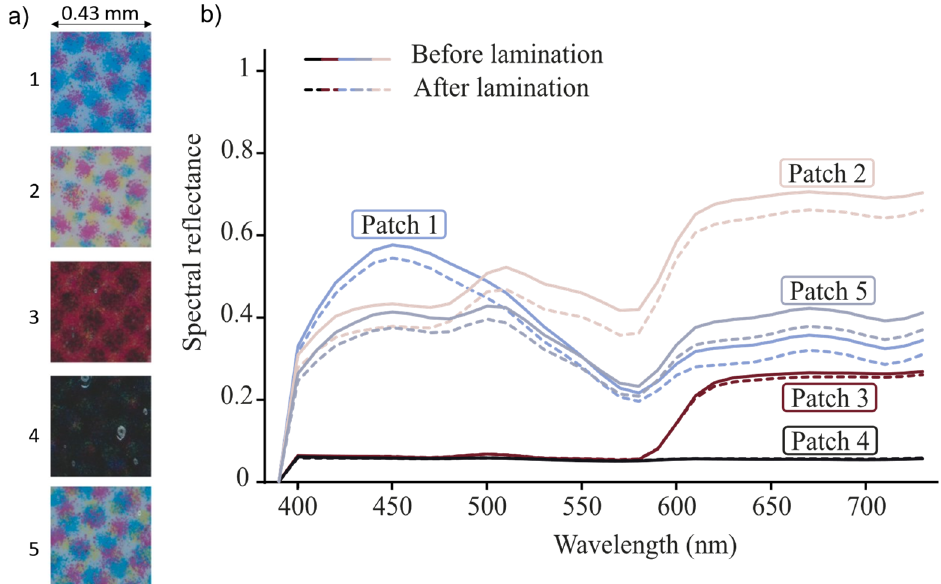
Figure 2. Example of halftones and impact of a coating layer on their reflectance. ( a ) Images of coated halftone patches with a microscope. ( b ) Spectrophotometric measurements of their reflectance before and after coating with a lamination film.